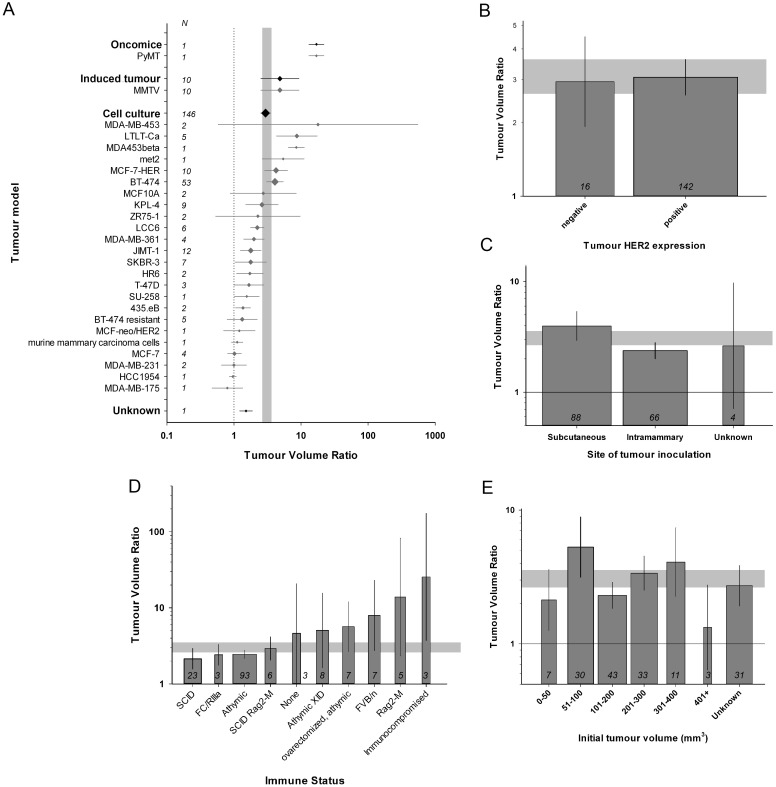
Stratification by animal and tumour model characteristics.(A) The specific xenograft model used were associated with a significant proportion of the between-study heterogeneity (χ2 = 4416, df = 23, P<0.00385). (B) Overexpression of HER2 in breast cancer tumours was associated with greater efficacy (χ2 = 160, df = 1, P<0.00385). (C) A greater reduction in tumour volume was observed with subcutaneous inoculation compared to intramammary route (χ2 = 810, df = 2, P<0.00385). (D) There is comorbidity related between-study heterogeneity (χ2 = 5130, df = 9, P<0.00385). The more commonly used athymic and SCID mice were associated with lower efficacies. (E) A significant proportion of between-study heterogeneity is accounted for by the tumour volume at treatment initiation, with a smaller treatment effect seen at either extreme (χ2 = 1042, df = 6, P<0.00385). The grey bands represent global 95% confidence intervals; diamonds (A) and columns (B-E) represent mean±95% CI and diamond size (A) column width (B-E) a measure of number of comparisons within each stratum; the number of comparisons is included inside the y-axis (A) and at the base of each column (B-E). The solid lines in A, C and E represent the level of neutral treatment effect.